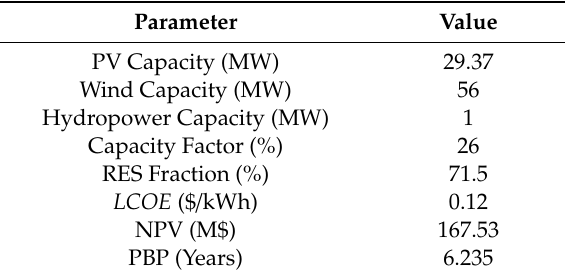
Table 3. Technical and economic performance parameters of the PV / wind-hydro system without